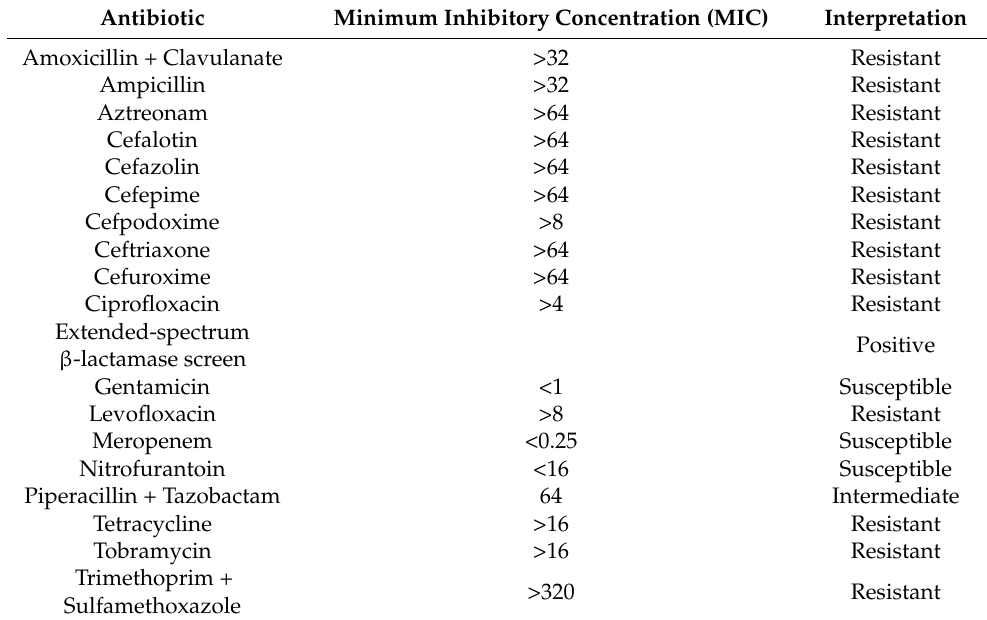
Table 1. Susceptibility testing of the urine